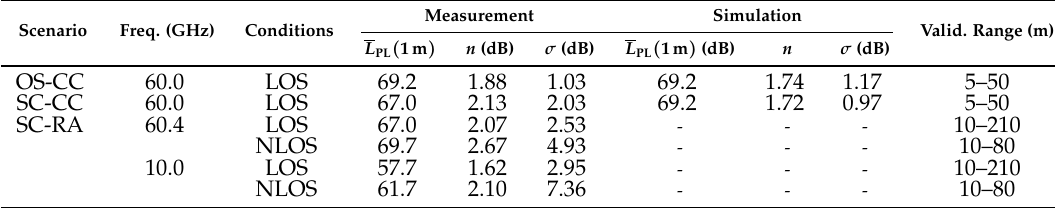
Table 2. Path loss (PL) parameters derived from measurements for all UMi scenarios and values from ray tracing simulations for “open square, city center” (OS-CC) and “street canyon, city center” (SC-CC)